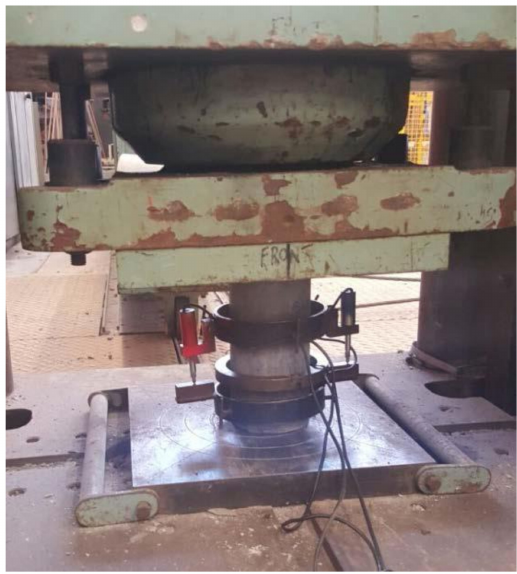
Figure 2. Test setup to measure the elastic modulus of concrete